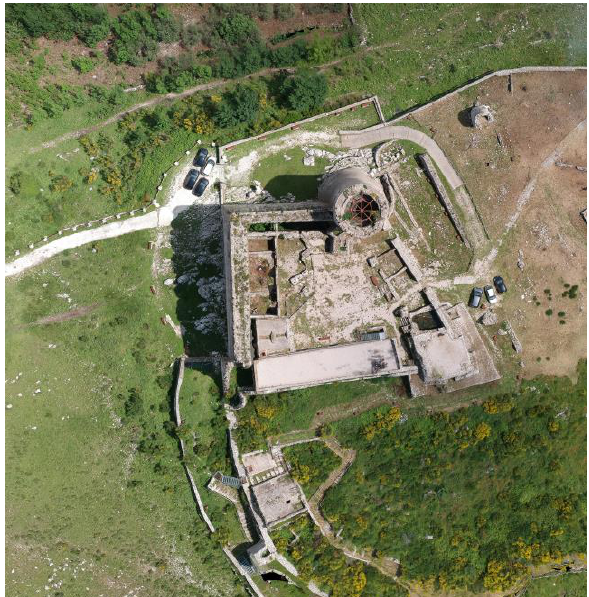
Figure 8: Ortho-photomosaic of the donjon.